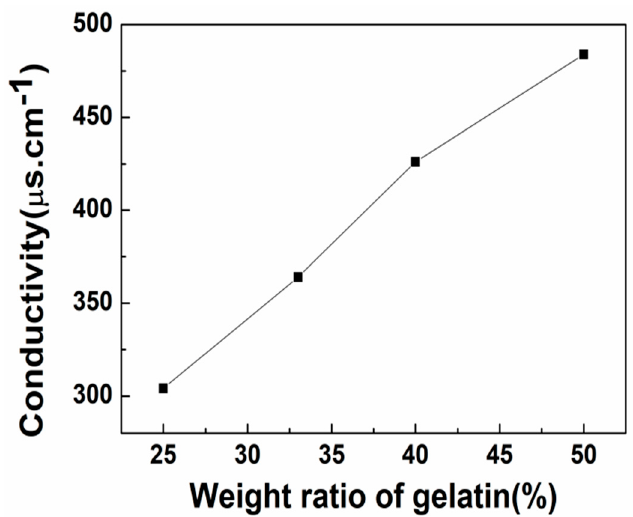
Figure 3. The relationship between the conductivity of blended gelatin / pullulan solutions and the weight ratios of gelatin (total polymer concentration = 25% w / v ).